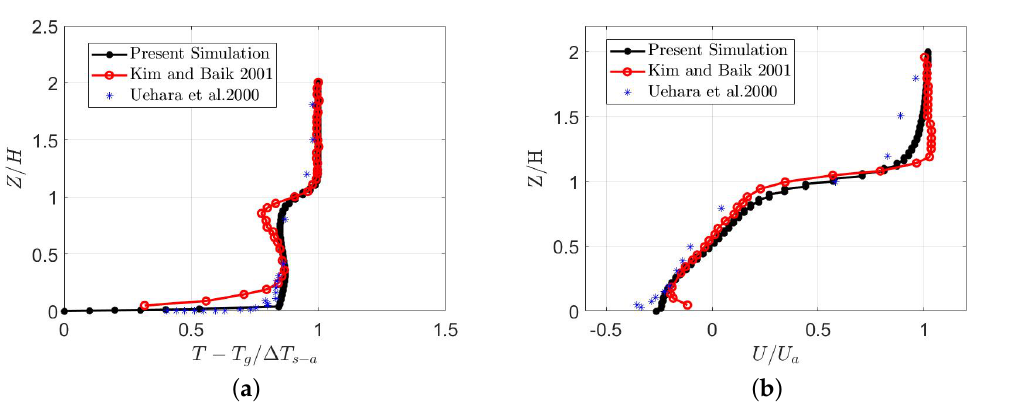
Figure 4. Variation of normalised velocity and temperature with the height in the middle of target street canyon with bottom heating ( a ) normalised temperature; ( b ) normalised velocity